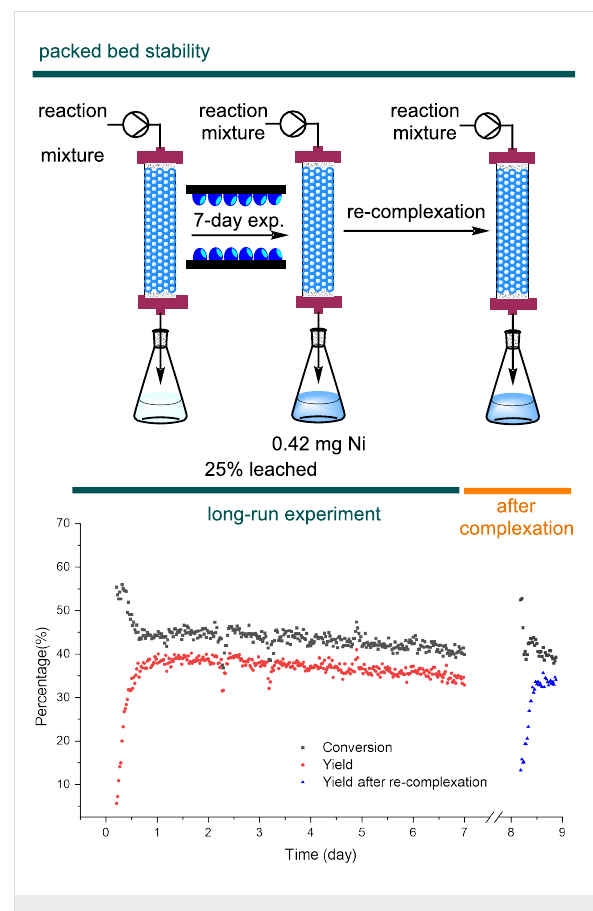
Figure 5: The production campaign of 1 for a seven day